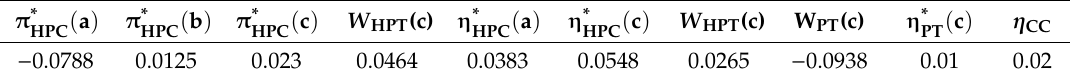
Table 2. Initial values of the model parameters.